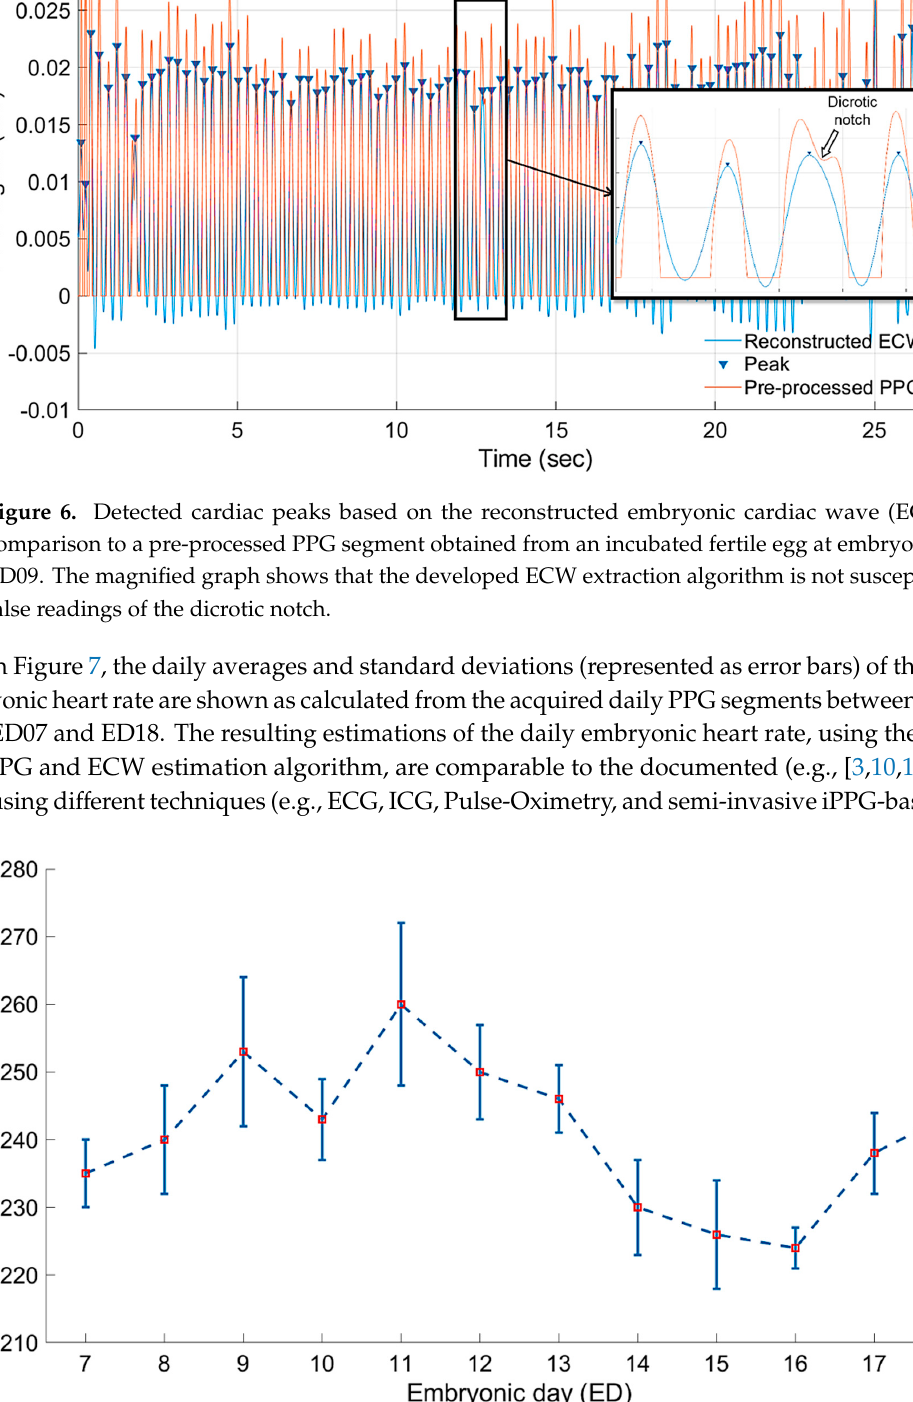
Figure 7. Average ± standard deviation (error bars) of estimated embryonic daily heart rate based on the acquired PPG segments using the developed Egg-PPG prototype and embryonic cardiac wave extraction algorithm.